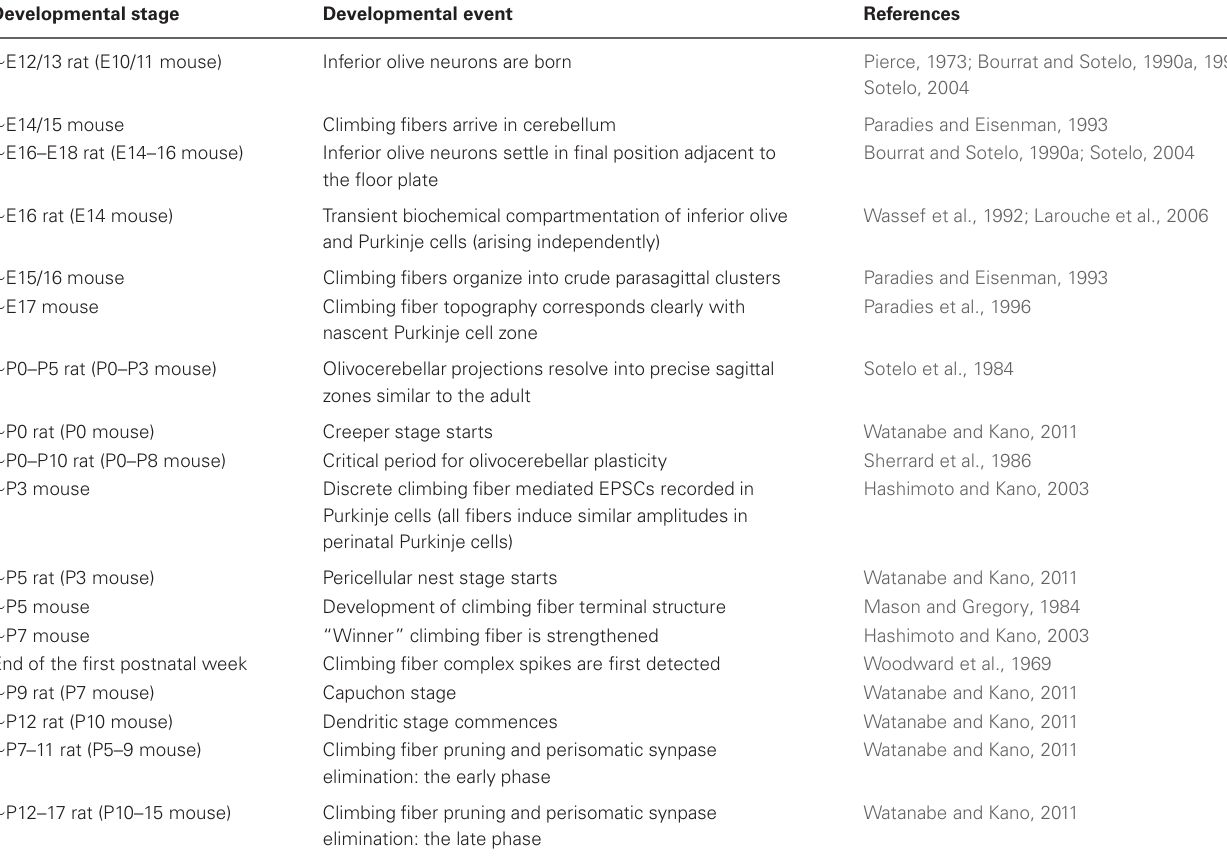
Table 2 | Timeline of olivocerebellar